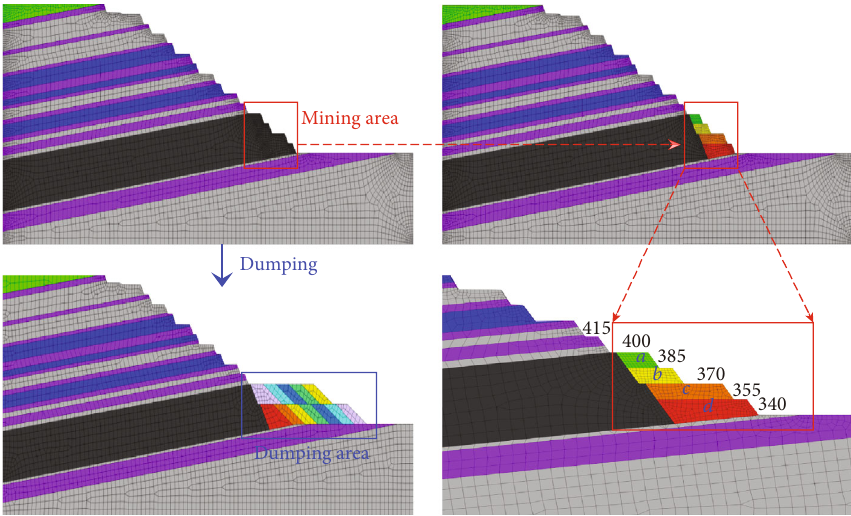
Figure 7: Numerical calculation model of south slope mining and inner drainage. Table 2: Physical and mechanical parameters of rock and soil.